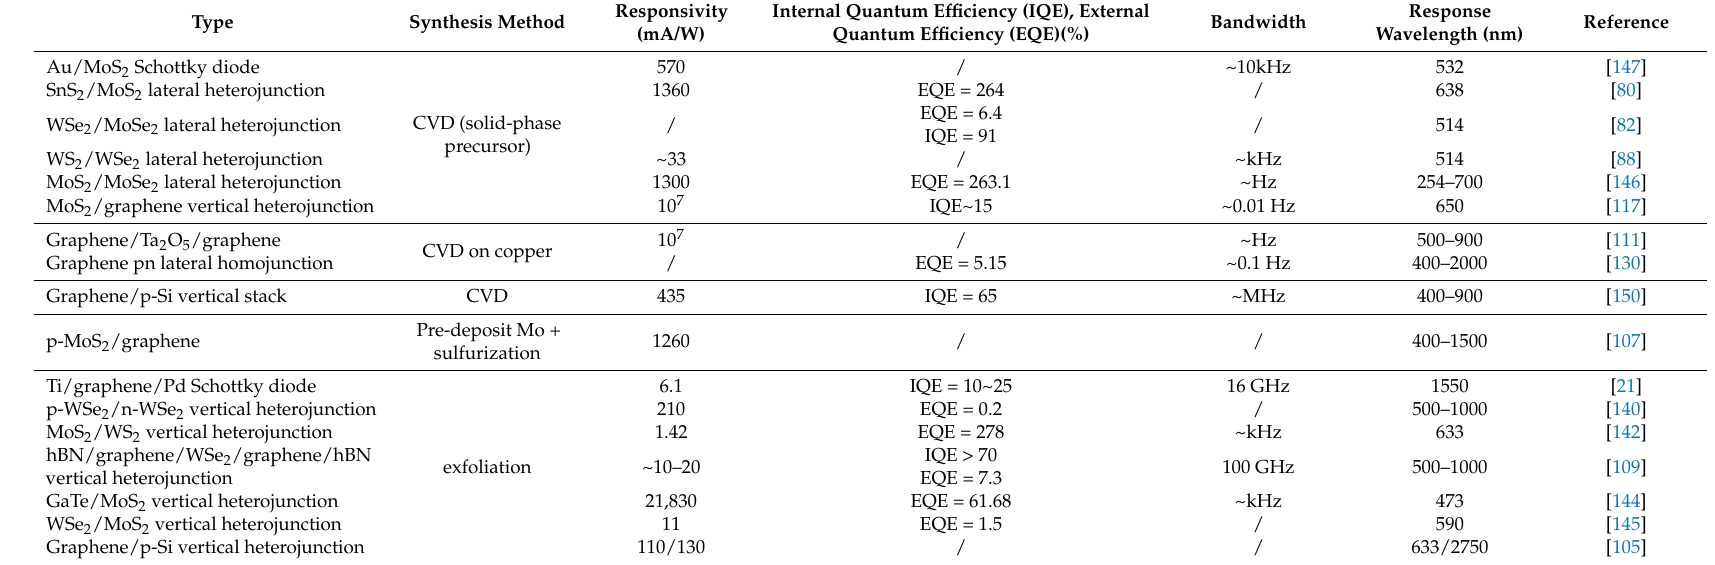
Table 2. Performance of junction-type 2D